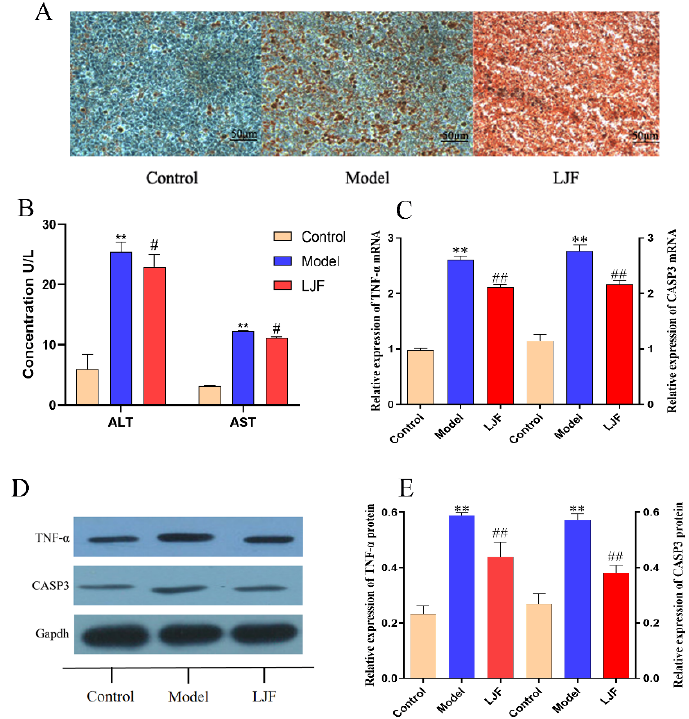
Figure 7. ( A ) The effect of LJF in HepG2 cells detected by oil red O staining. ( B ) The effect of LJF on the content of ALT and AST in HepG2 cells. ( C ) The effect of LJF on the expression of TNF- α and CAPS3 mRNA in HepG2 cells. ( D , E ) The effect of LJF on the expression of TNF- α and CAPS3 protein in HepG2 cells. ** , p < 0.01; #, p < 0.05; ##, p < 0.01. ALT, alanine transaminase; AST, aspartate aminotransferase; TNF- α , tumor necrosis factor; CASP3, caspase 3.